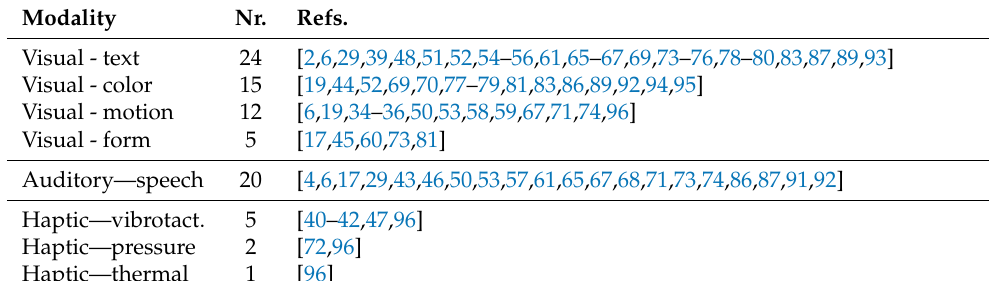
Table 5. Overview of modalities used by papers to convey information with the goal of transparency.